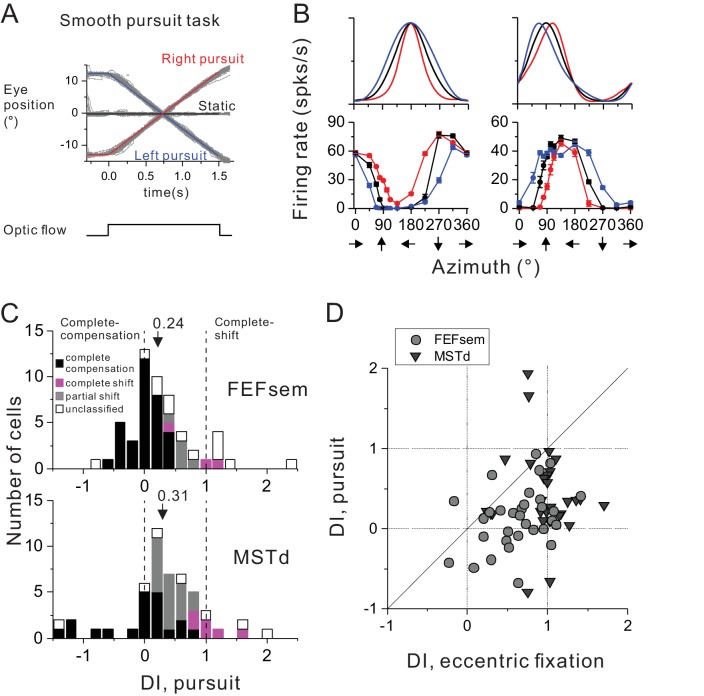
Comparison of spatial reference frames with smooth pursuit eye movement compensation.(A) Experimental paradigm for smooth pursuit eye movement. Monkeys were required to pursue a smooth moving target crossing the screen either from right to left (blue curve) or from left to right (red curve). These conditions were interleaved with a no-pursuit condition (central fixation, black curve). Gray curves are the raw eye traces from an example block. (B) Heading tuning curves from two hypothetical (top) and two example FEFsem (bottom) neurons under different pursuit conditions. Color is the same as in (A). (C) DI distributions under the pursuit protocol in FEFsem (upper panel) and MSTd (lower panel). Arrowheads indicate mean values. Vertical dashed lines indicate head-centered/complete compensation (DI = 0) or eye-centered/complete shift (DI = 1). Black bars: complete compensation for eye rotation; Magenta bars: complete shift from eye rotation; Gray bars: partial shift; Open bars: unclassified group. (D) Direct comparison of DIs between pursuit and eccentric fixation on a cell by cell basis. Each point represents one neuron. Circle: FEFsem, N = 36; Triangle: MSTd, N = 32.10.7554/eLife.29809.012Figure 4—source data 1.Raw data for Figure 4C.